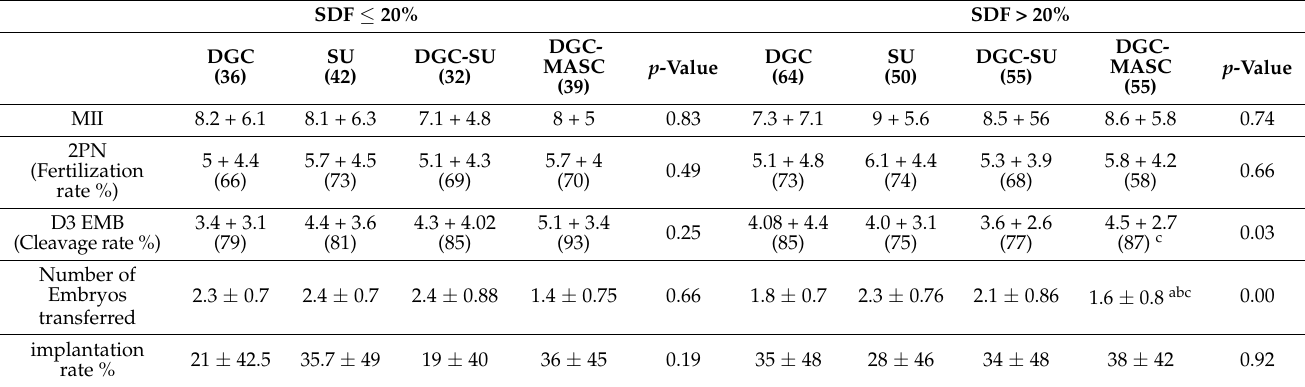
Table 5. MII (oocyte metaphase two), 2PN (two pronuclei), fertilization rate, D3 EMB (day three embryo), cleavage rate and number (N) of embryos transferred in the four processing group popu- lations with < 20 and ≥20% SDF in each studied population.